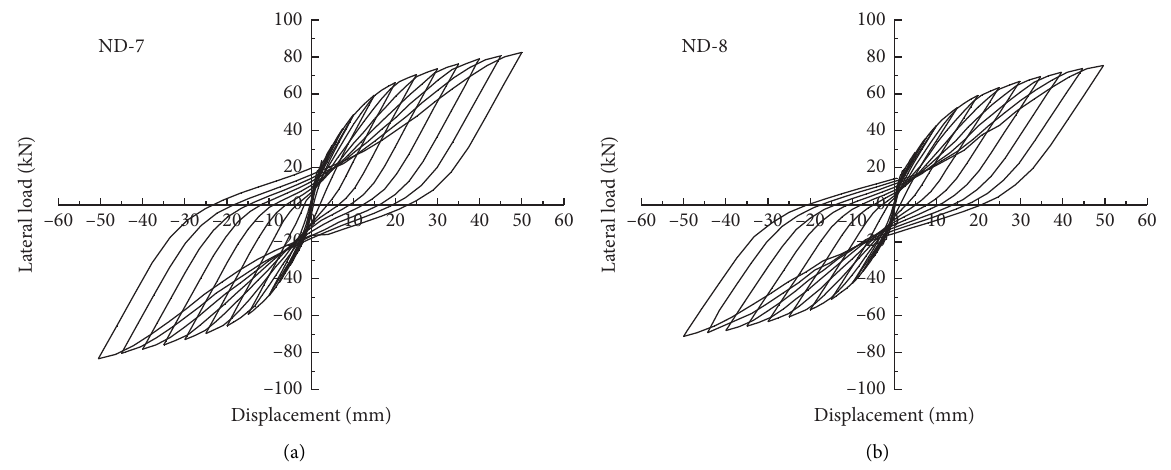
Figure 28: Hysteretic curves of Slit width 30mm. (a) Z -direction constrain. (b) Without